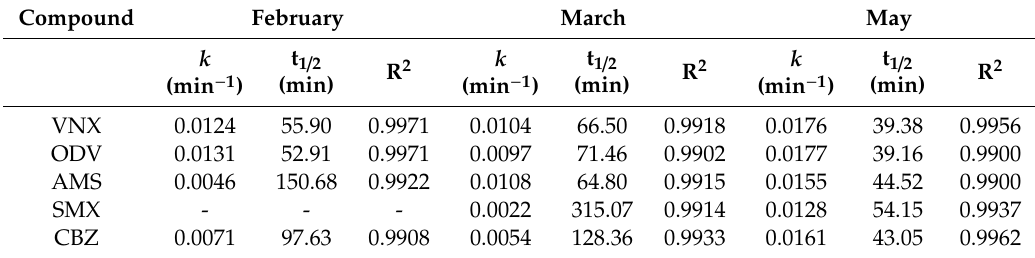
Table 3. Kinetic parameters of PhACs photocatalytic degradation in TiO 2 suspensions in the three sampling months in hospital wastewater e ffl